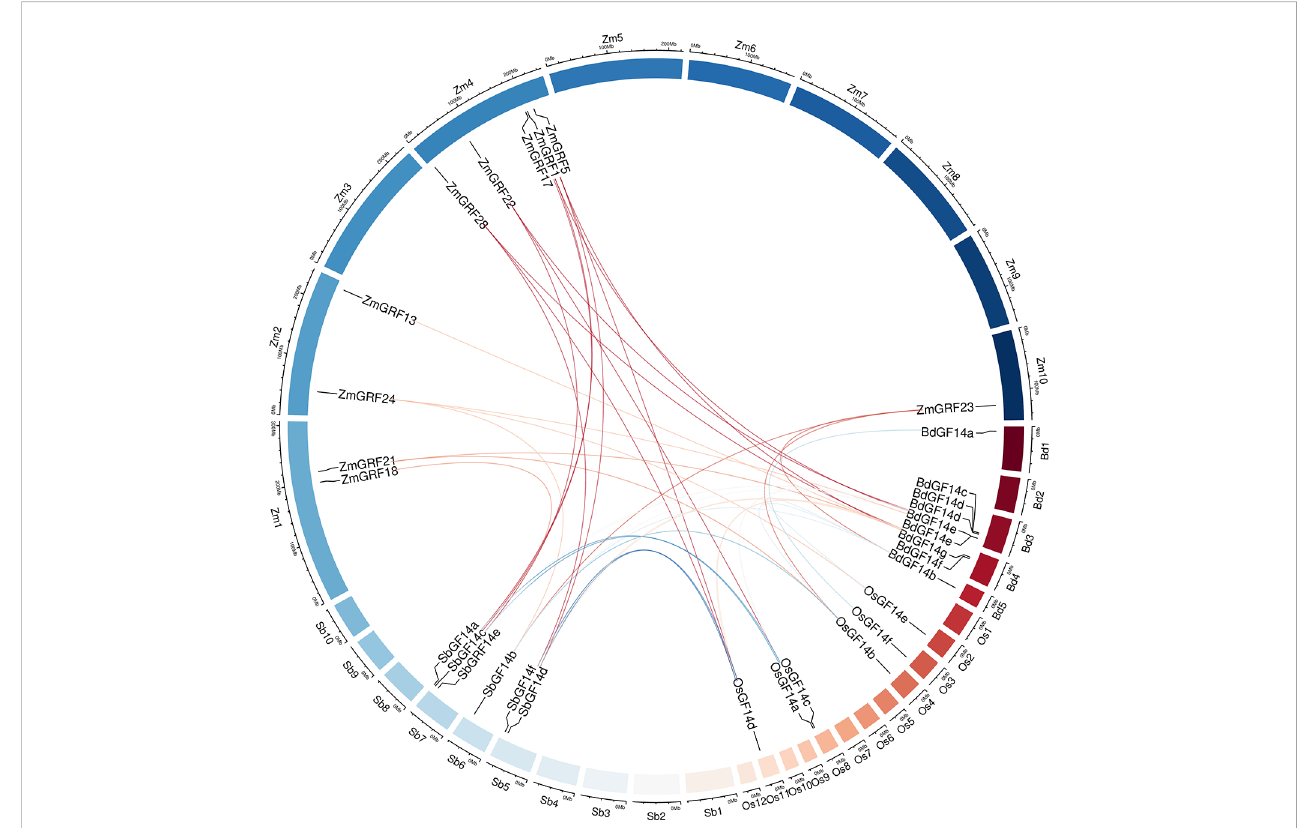
FIGURE 4 Circle plot showing segmentally duplicated 14-3-3 genes on maize, sorghum, brachypodium, and rice chromosomes. Zm1 – 10 represented maize chromosome 1 – 10, Sb1 – 10 represented sorghum chromosome, Bd1 – 5 represented brachypodium chromosome and Os1 – 12 represented rice chromosome, all chromosome indicated by colored boxes. Chromosome box numbers represent sequence lengths in megabases. lines indicated duplicated 14-3-3 gene pairs.